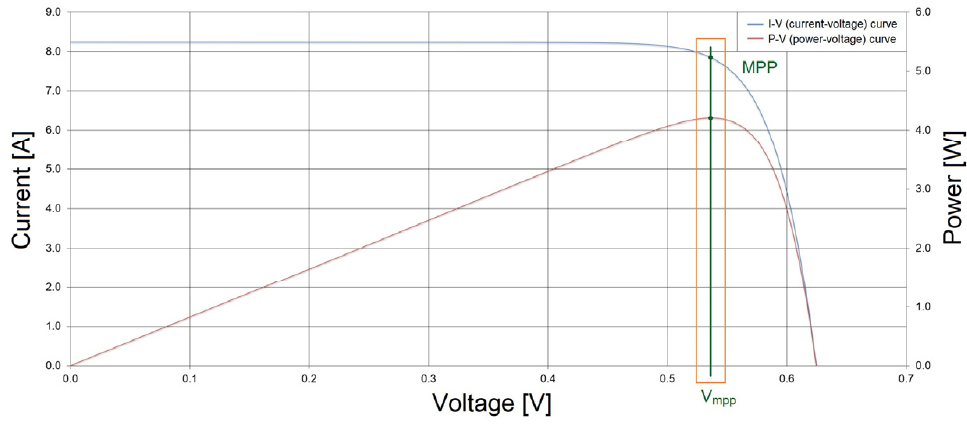
Figure 1. I–V and P–V of a PV cell at STC.